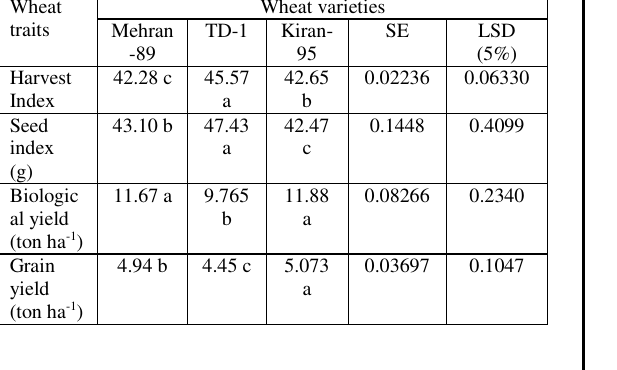
Table 2: Varietal variability for some yield, traits (mean data of two years 2008-09 & 2009-10) Wheat traits